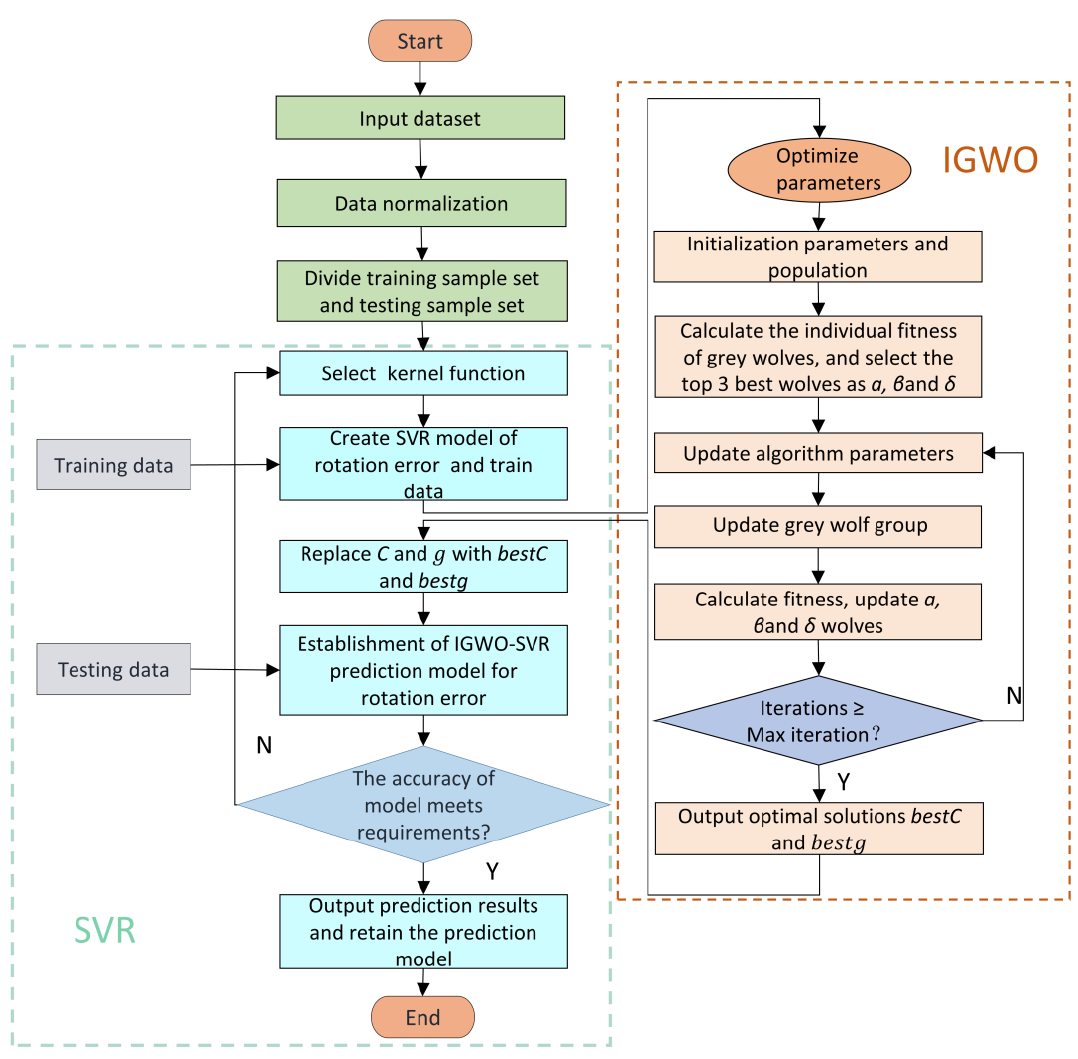
Figure 7. Flowchart of the IGWO-SVR method.